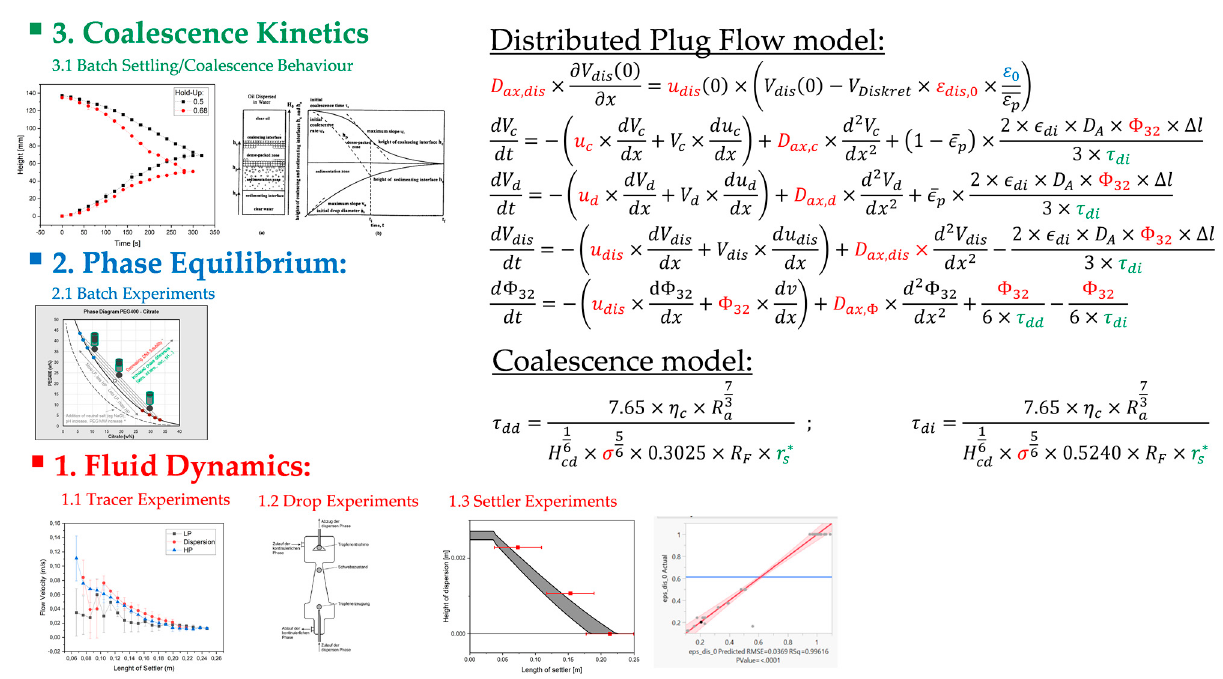
Figure 11. Summary of the model parameter determination concept and qualitive examples of the experimental data used [3,26,28].